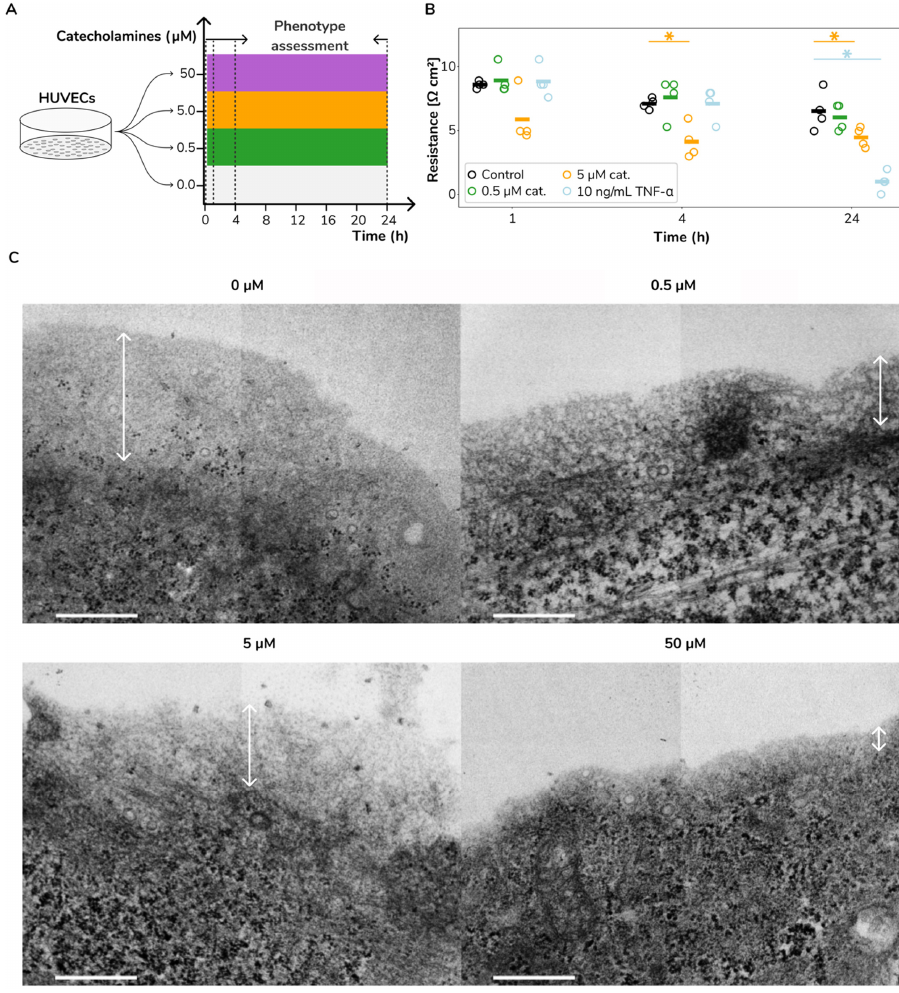
Figure 1. Catecholamine stimulation leads to increased vascular permeability and glycocalyx loss. ( A ) Overall experimental design. ( B ). Cell culture permeability measurements at 1, 4 and 24 h after treatment. Stars represent significant differences (Mann–Whitney U test; p < 0.05) between treated cultures (green, 0.5 μ M equimolar adrenaline and noradrenaline; orange, 5 μ M equimolar adrenaline and noradrenaline; and sky blue, 10 ng/mL TNF- α ) and their corresponding time refer- ences (denoted in black colour). ( C ). TEM images of the eGC following 4 h of adrenaline and nora- drenaline equimolar catecholamine stimulation (0, 0.5, 5 and 50 μ M). We observed a substantial glycocalyx loss upon catecholamine stimulation. The reference bar indicates 500 nm in length and magnification of 20,000×. Double-headed white arrows highlight glycocalyx thickness.